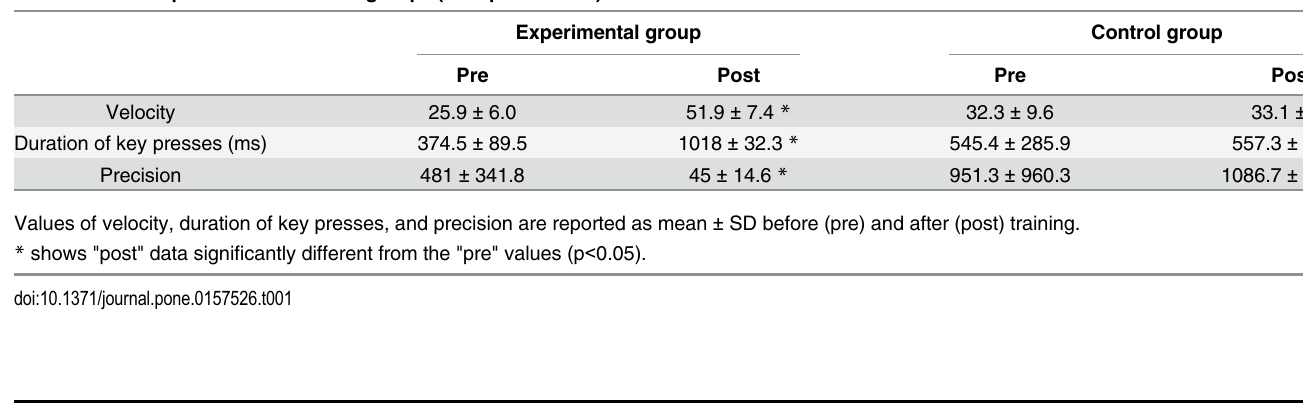
Table 1. Musical performance of both groups (MIDI